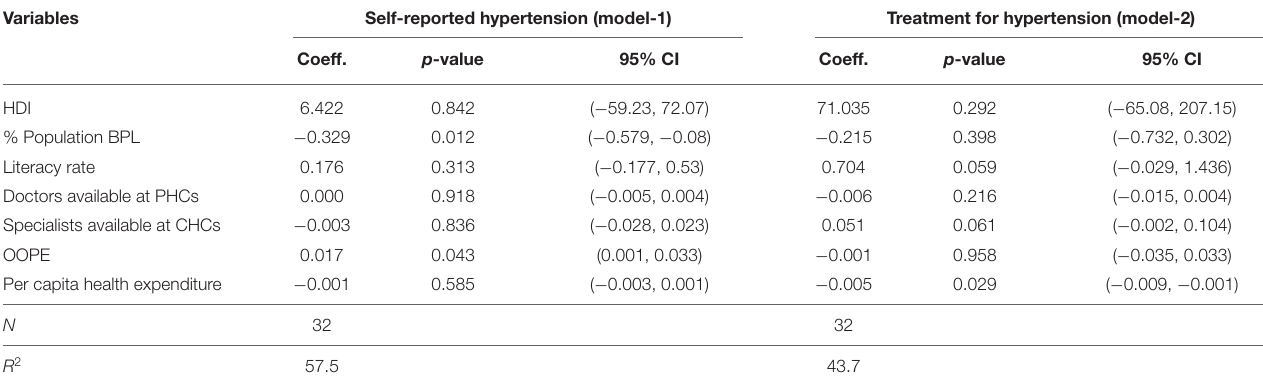
TABLE 5 | Regression results for state performance- self-reported HT and its treatment, 2017–18. Variables Self-reported hypertension (model-1) Treatment for hypertension